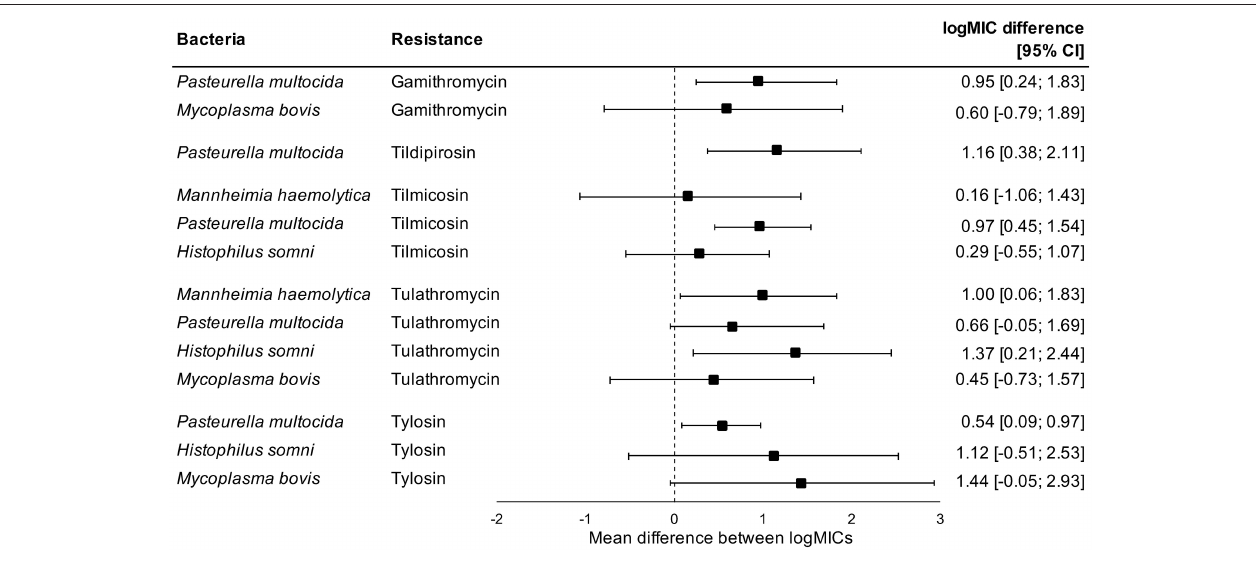
FIGURE 3 | Mean difference between antimicrobial-specific logMICs of bacteria isolated at REPROCESSING from the respiratory tract of animals treated, and not treated parenterally with macrolides at feedlot induction. Model includes observations from all operations, including ones that fed tylosin to control liver abscesses. Sensitivity analysis indicated that effects of parenteral administration of macrolides toward the logMIC of tylosin and gamithromycin in P. multocida , and tulathromycin in H. somni were statistically significant only when observations from operations that fed tylosin after induction were kept in